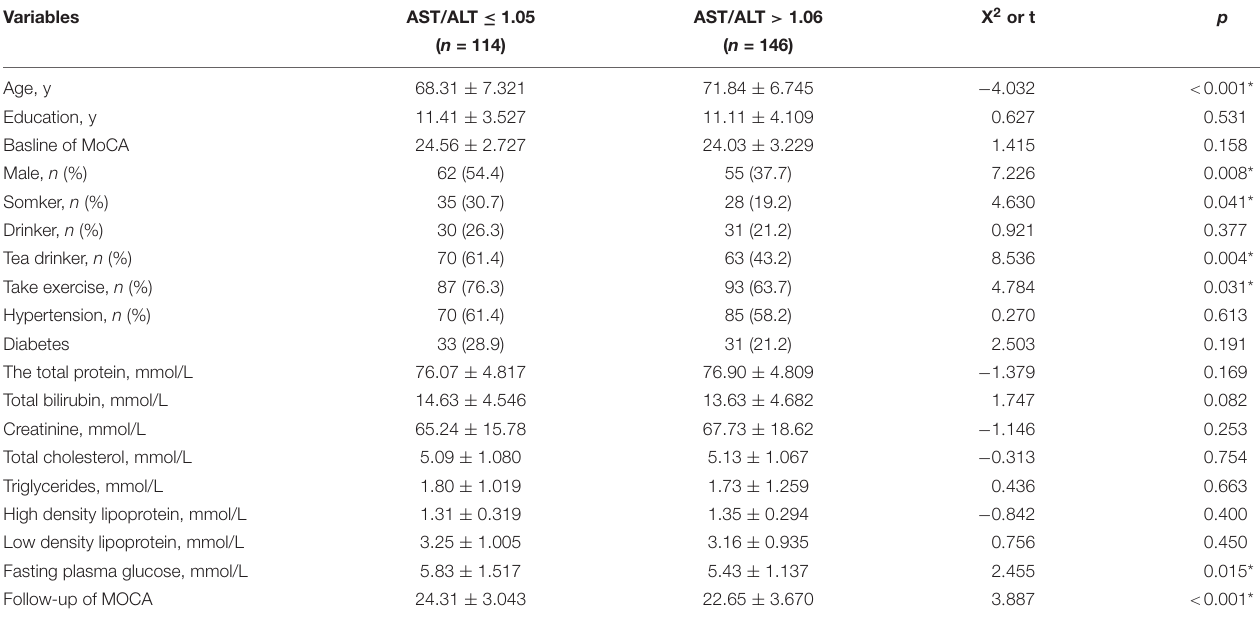
TABLE 3 | Relationship between AST/ALT and baseline demographic characteristics.